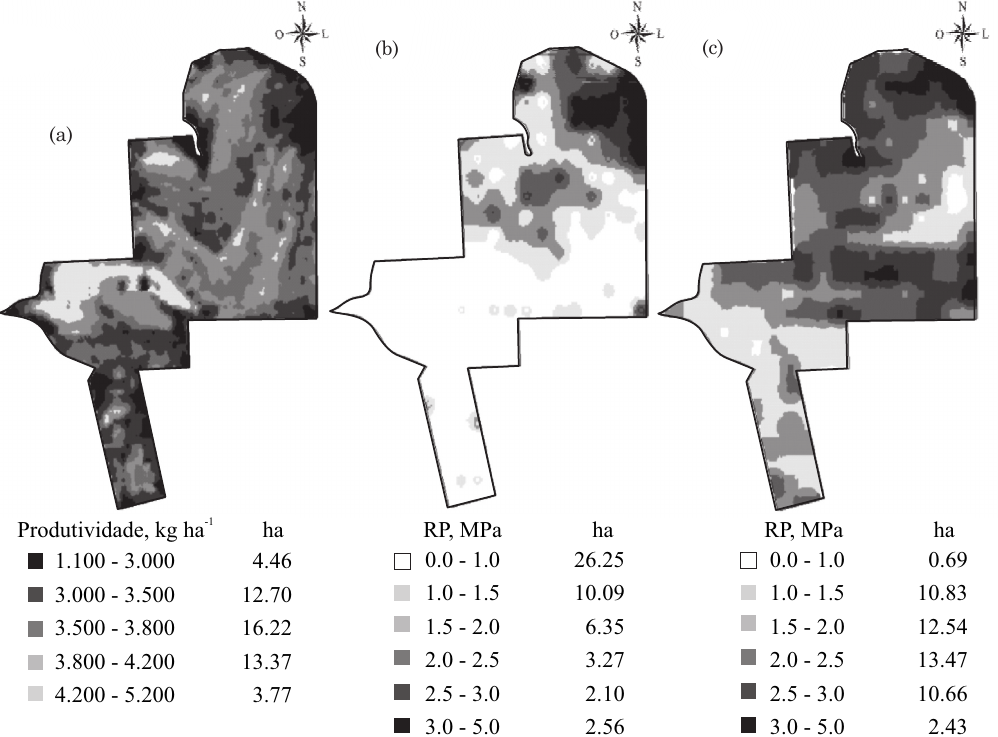
Figura 3. Produtividade da cultura da soja na safra de 2008/09 (a), resistência máxima à penetração (RP) determinada por penetrômetro digital após o manejo da cultura de cobertura (b) e determinada após a colheita da soja (c) em Latossolo